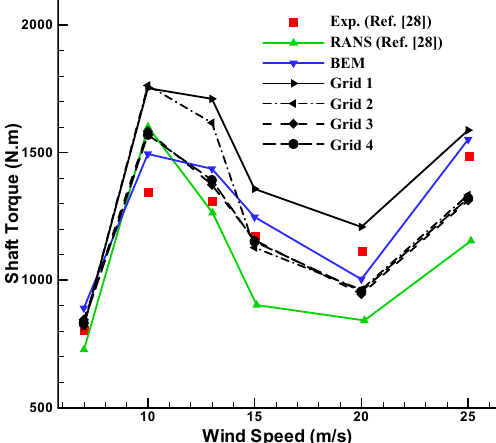
Figure 9. Comparison of experimental data, reference results, and present results of shaft torque.